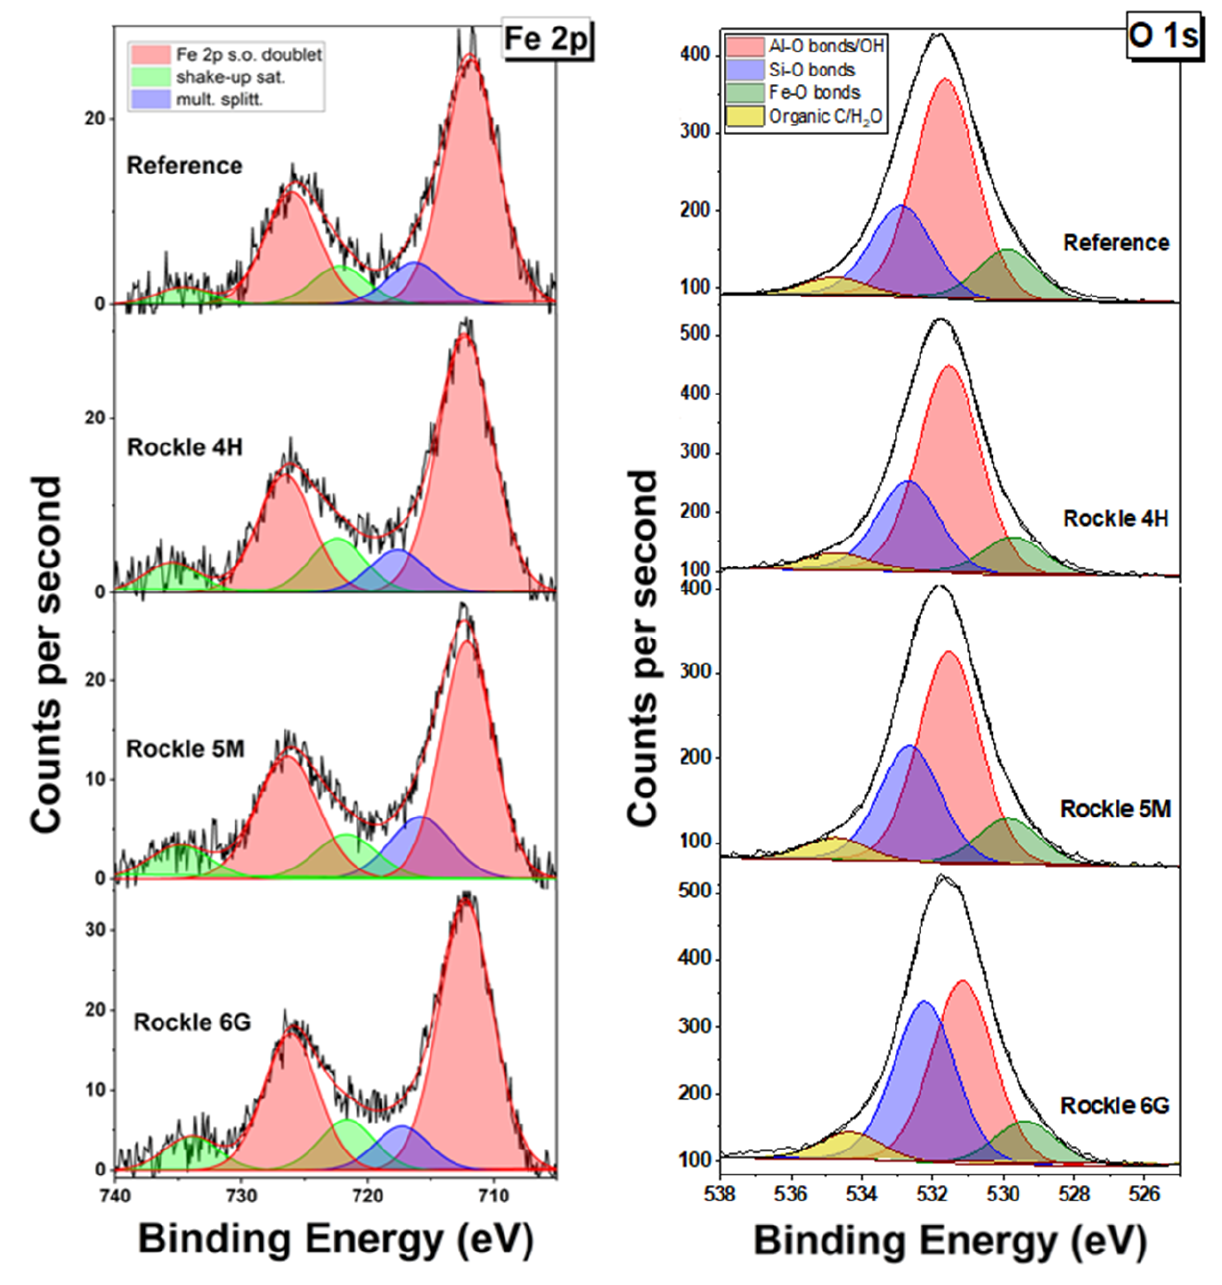
Figure 10. XPS narrow scan Fe 2p and O 1s spectra recorded from the Rokle samples: reference, 4H: close to heater interface, 5M: middle, and 6G: close to granite interface; i.e., at 1.67 cm, 5.00 cm and 8.33 cm from the heater contact, respectively.